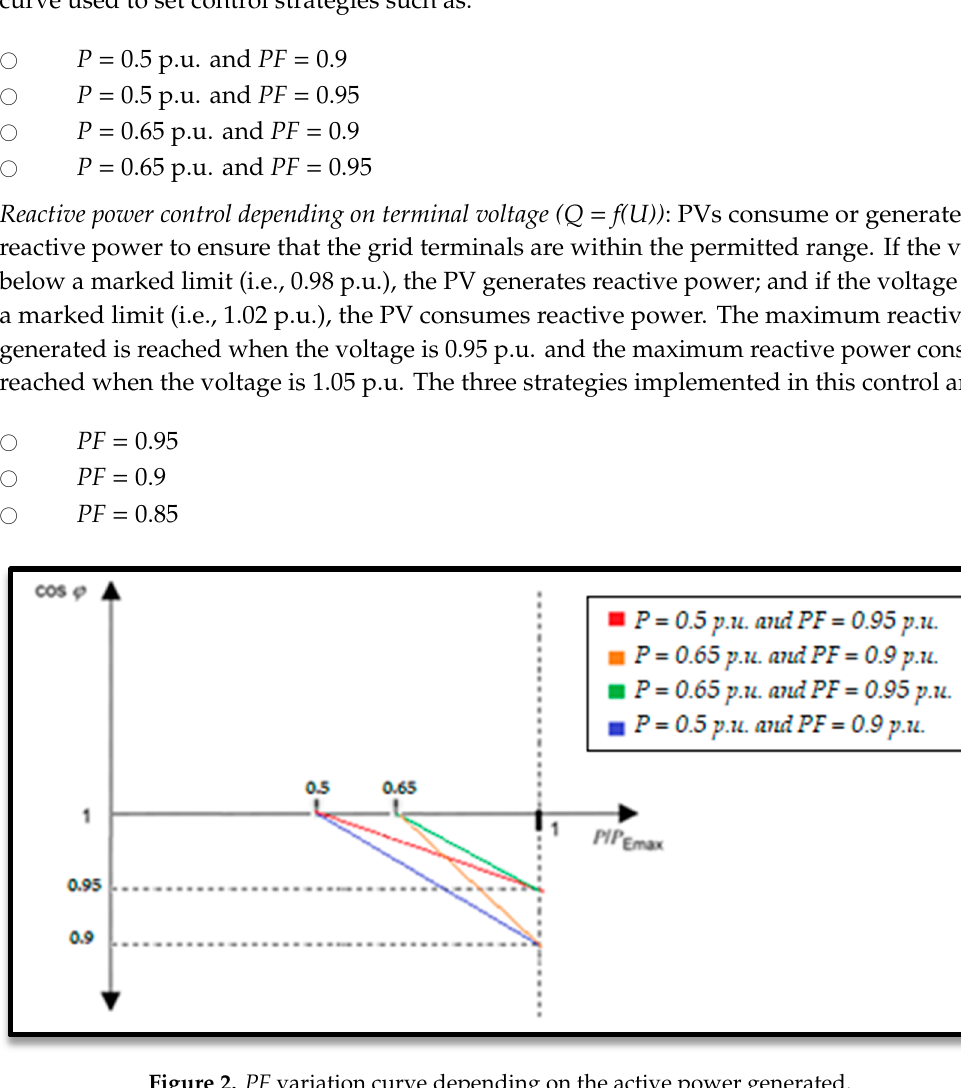
Figure 3. LV network topology of the case study.